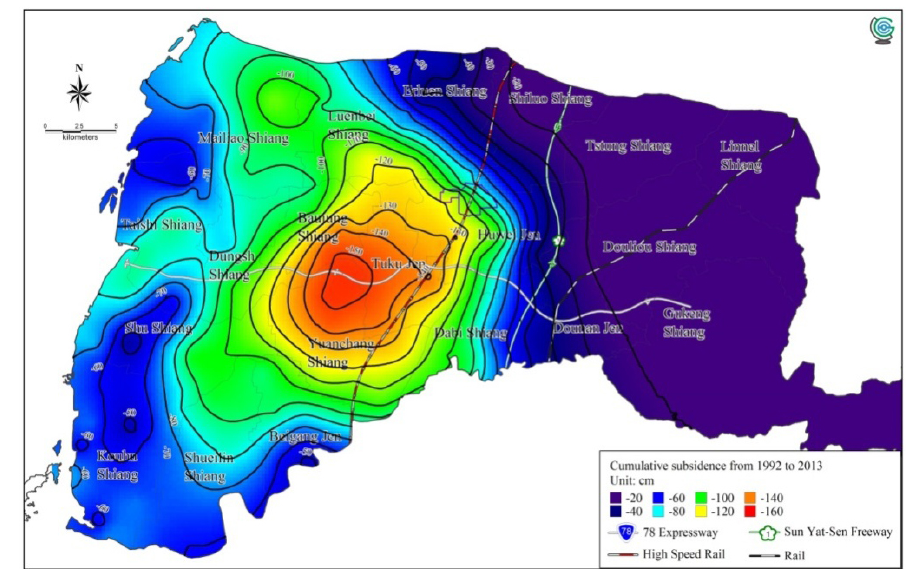
Figure 5. Cumulative subsidence derive from leveling over 1992–2013.